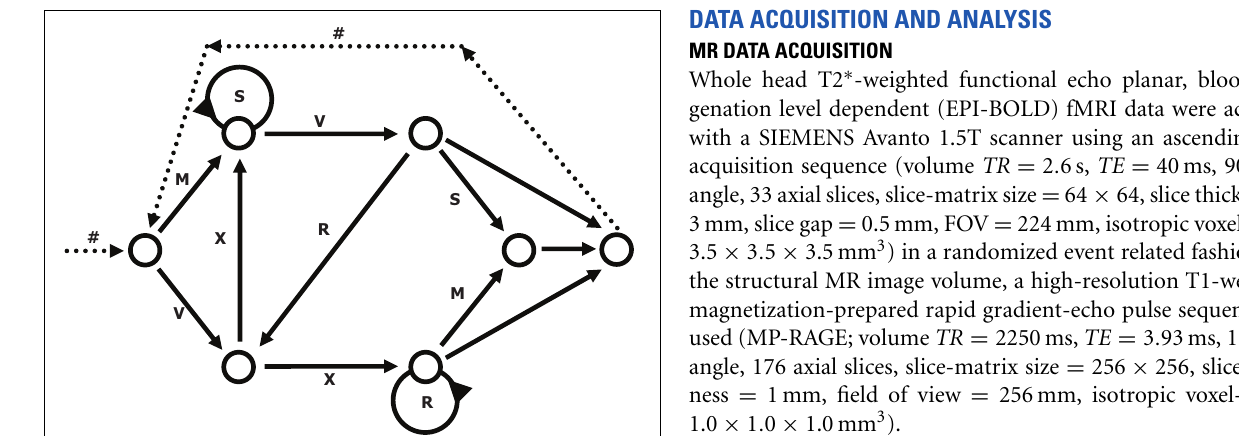
Presentation (nbs.neuro-bs.com). The subjects were instructed to retype the sequence on a keyboard. No performance feedback was provided and only grammatical sequences were presented. The acquisition session lasted approximately 20–40 min each day for 5 consecutive